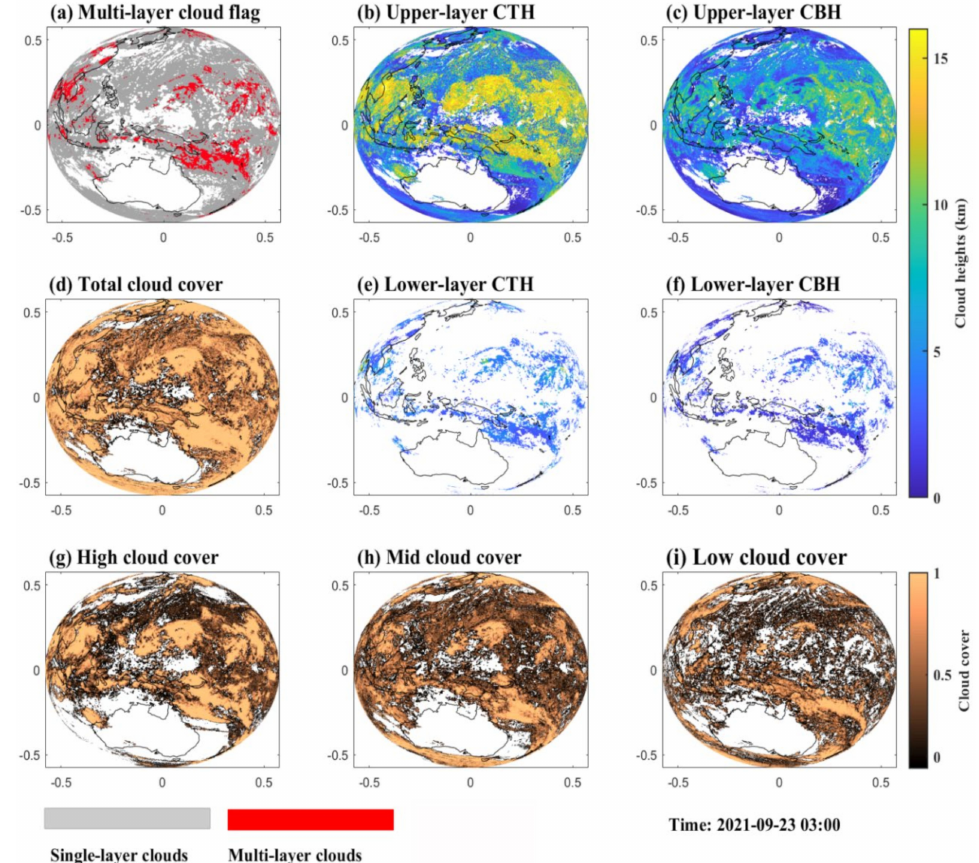
Figure 8. An example of LCC estimate based on AHI full-disk measurements on 23 September 2021. ( a ) multi-layer cloud detection, ( b , c ) represent the CTH and CBH retrievals of upper-layer clouds, respectively, and ( e , f ) are the CTH and CBH retrievals of lower-layer clouds, ( d ) is the total cloud cover, and ( g – i ) represent the high, medium, and low cloud cover,